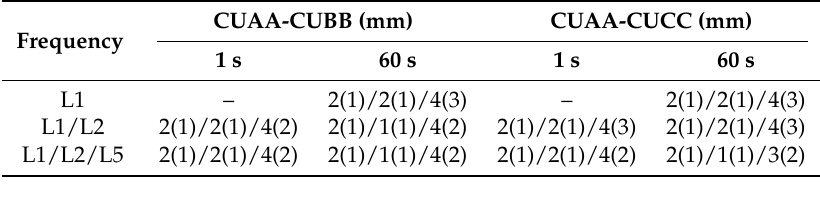
Figure 15. Ambiguity-fixed baseline errors for CUAA-CUBB in the phase-only two-epoch case. The time span between the two epochs is 30 s. The green dots represent the ambiguity-correctly-fixed solutions, and the blue dots represent their 95% formal confidence intervals. Note that the scales in different sub-figures are different. Table 4. Empirical and average formal (in brackets) standard deviations of the ambiguity-fixed baseline errors for the phase-only two-epoch scenario. The data on DOY 240, 2018, was used for the computation. The results are given in the format of the north/east/up directions.